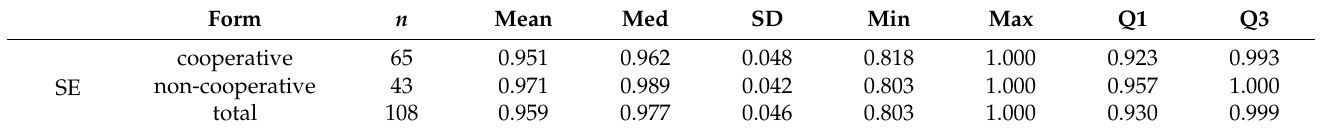
Table 8. Descriptive statistics of SE scores (authors’ calculations based on